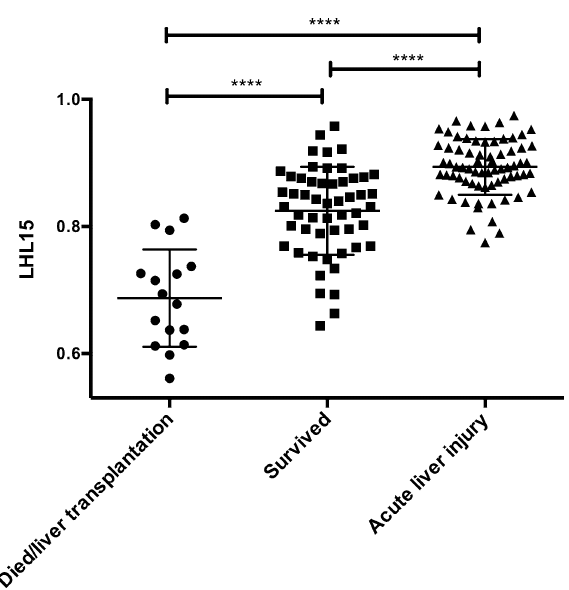
Figure 2. LHL15 levels in patients with severe acute liver injury. Bars indicate medians and standard deviations. For within-group comparisons, a one-way analysis of variance with repeated measures was performed followed by a Bonferroni post-hoc correction. **** P <